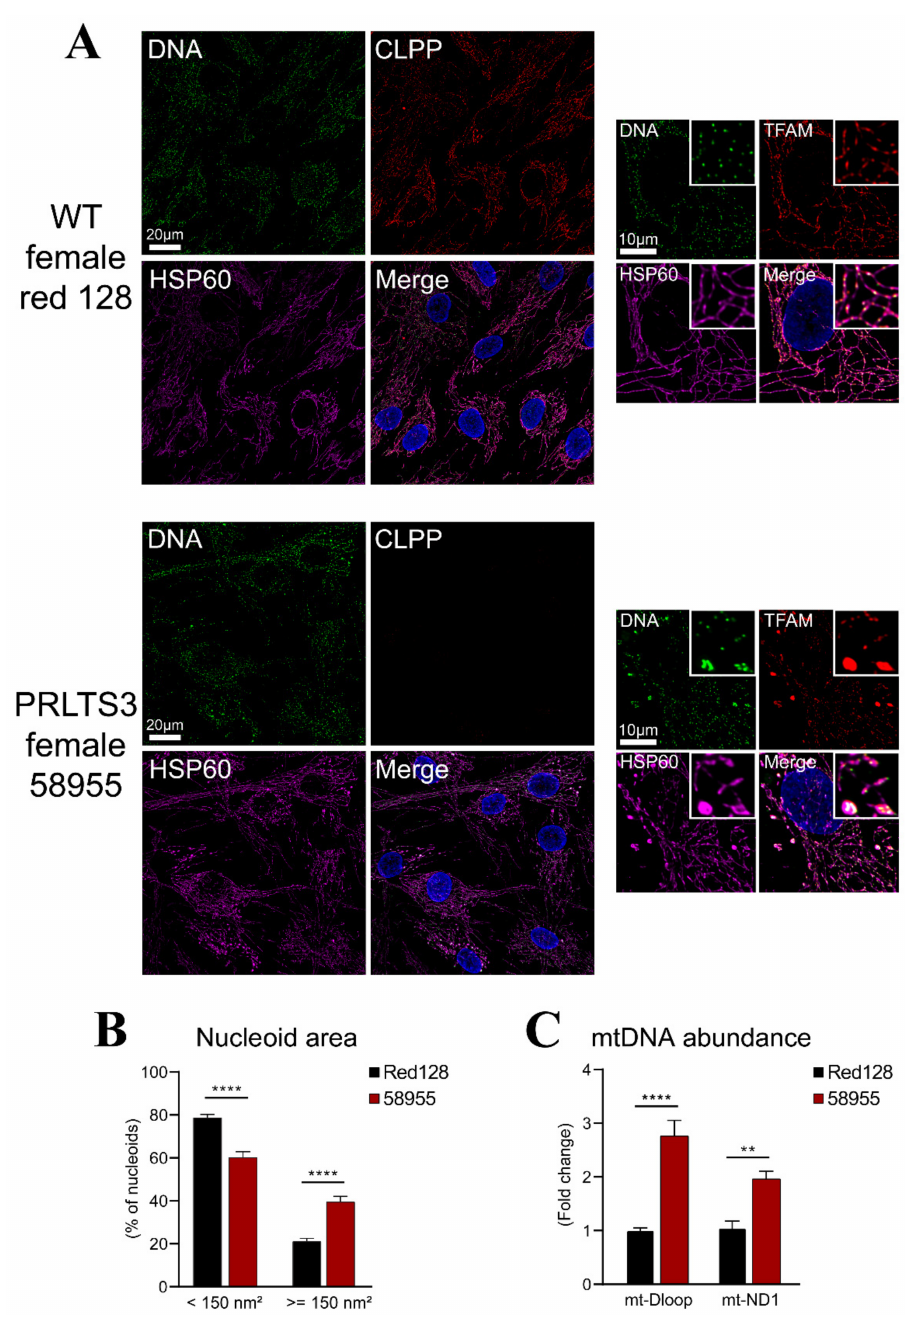
Figure 5. Nucleoid misassembly in PRLTS3 fibroblasts. ( A ) Immunocytochemistry with HSP60 as a mitochondrial marker (purple) and DAPI as a nuclear marker (blue) showed PRLTS3 fibroblasts with a larger TFAM-positive area (red) that contain multiple mitochondrial DNA signals upon deconvolution (green). ( B ) Quantification of nucleoid size showed significant enlargement. ( C ) Copy number quantification by qPCR for two sites within mtDNA also revealed significant increases. ** p < 0.01; **** p <